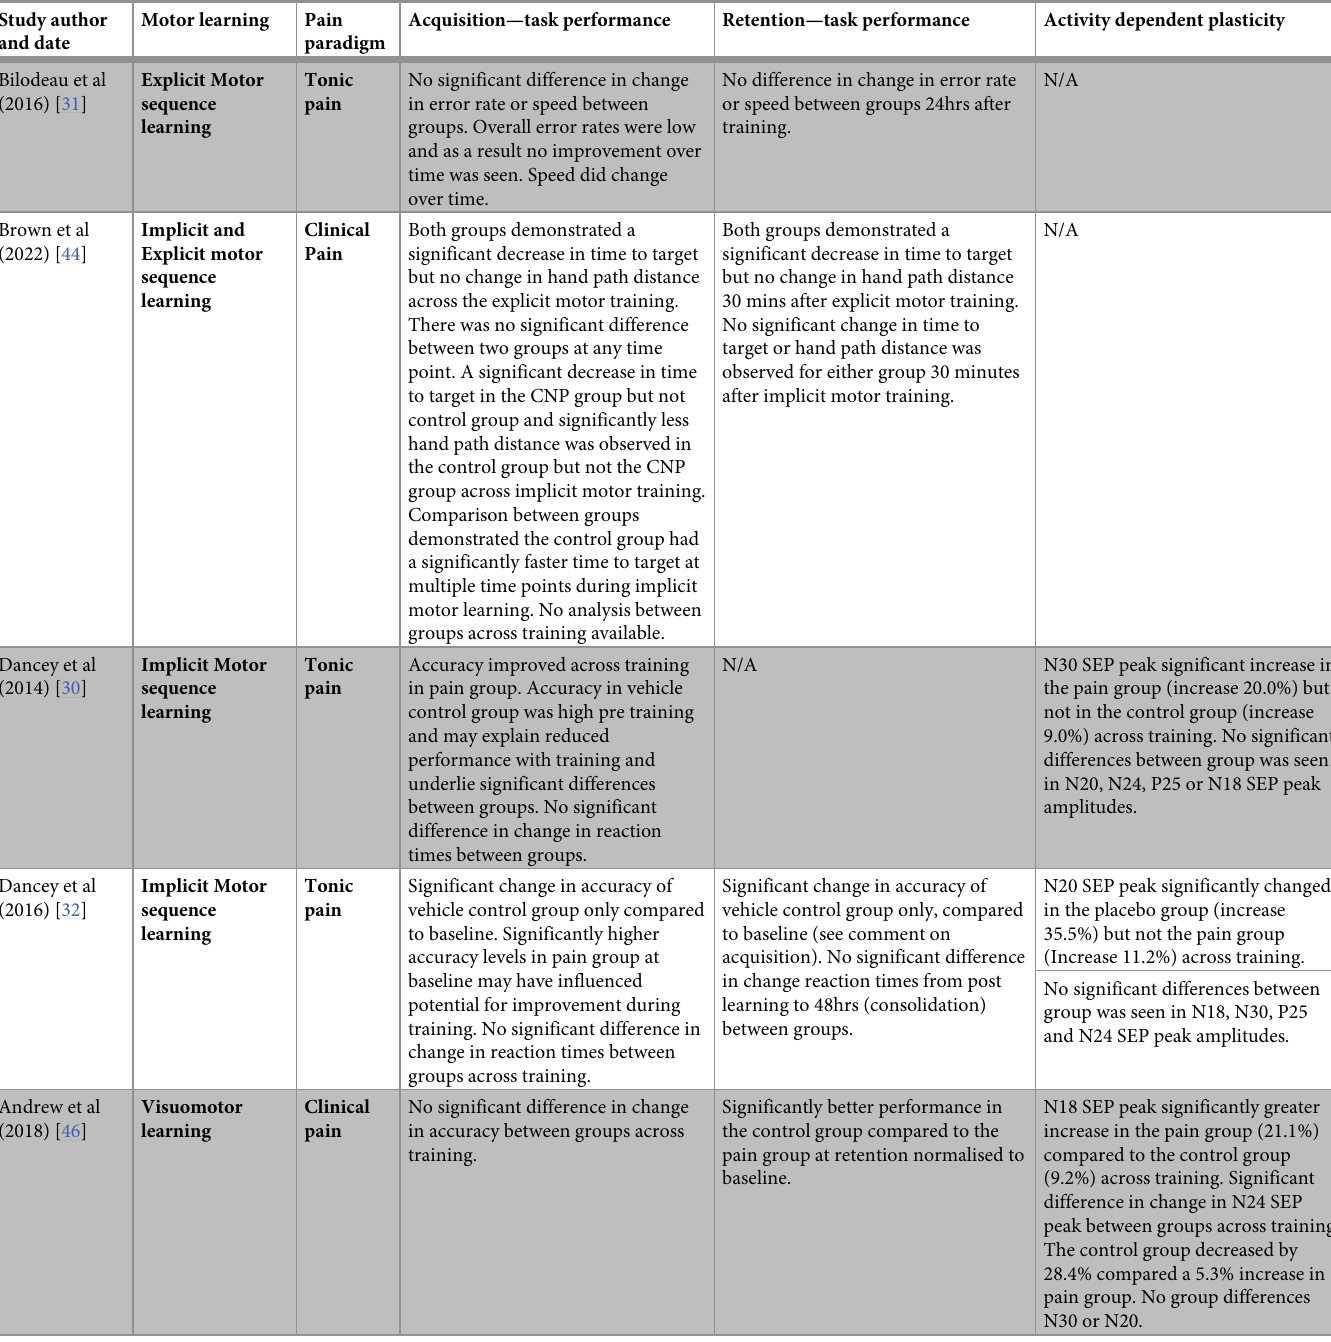
Table 3. Summary of findings for each study for task performance and activity dependent plasticity